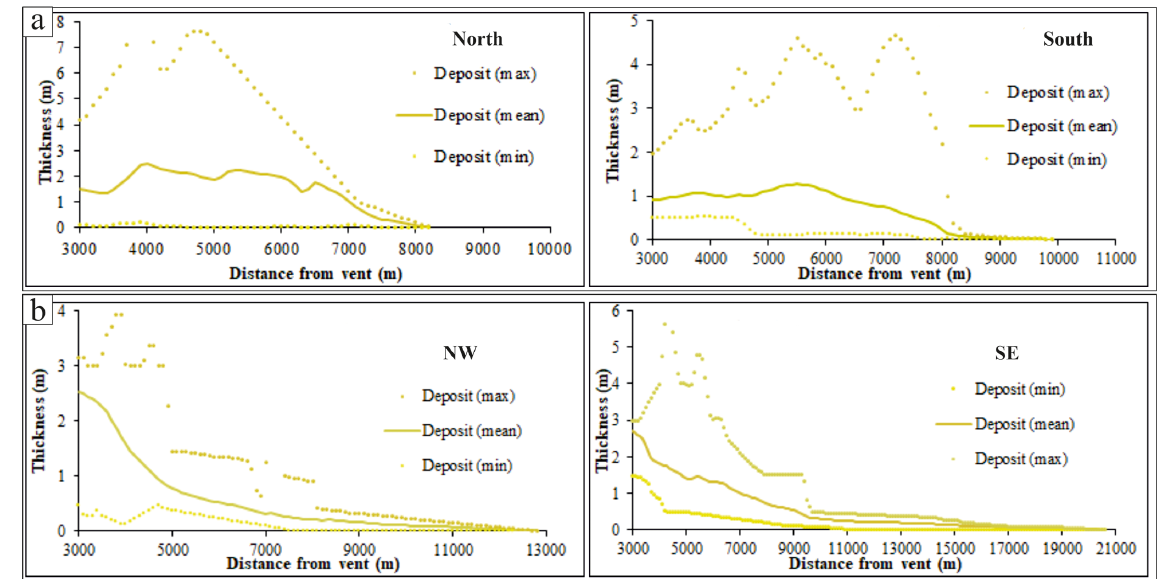
Figure B1. Deposit thickness for (a) EU3pf and (b) EU4b/c units. “Max”, “Mean” and “Min” refer to, respectively, the maximum, mean and minimum thicknesses measured along each circle described in Sect.